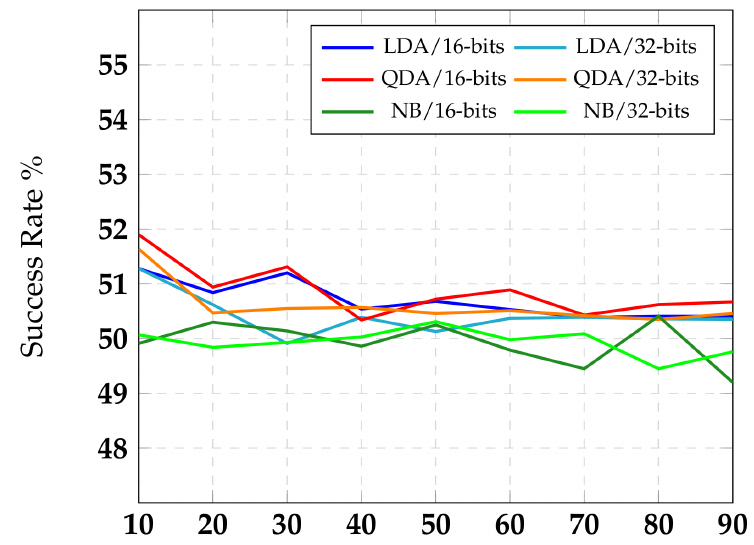
Figure 3. Success rate of the RNS